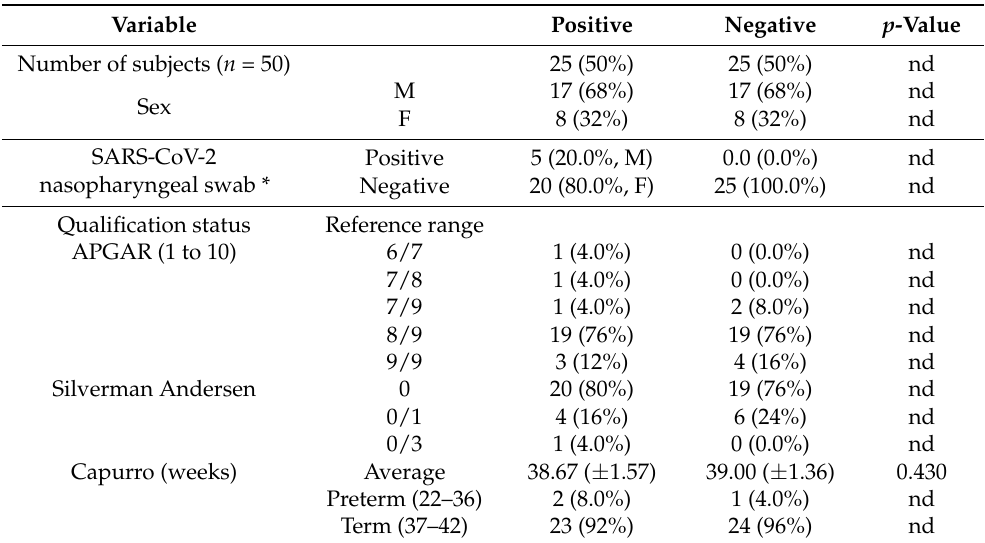
Table 2. Data of 50 participant neonates grouped according to SARS-CoV-2 rectal swab RT-ddPCR